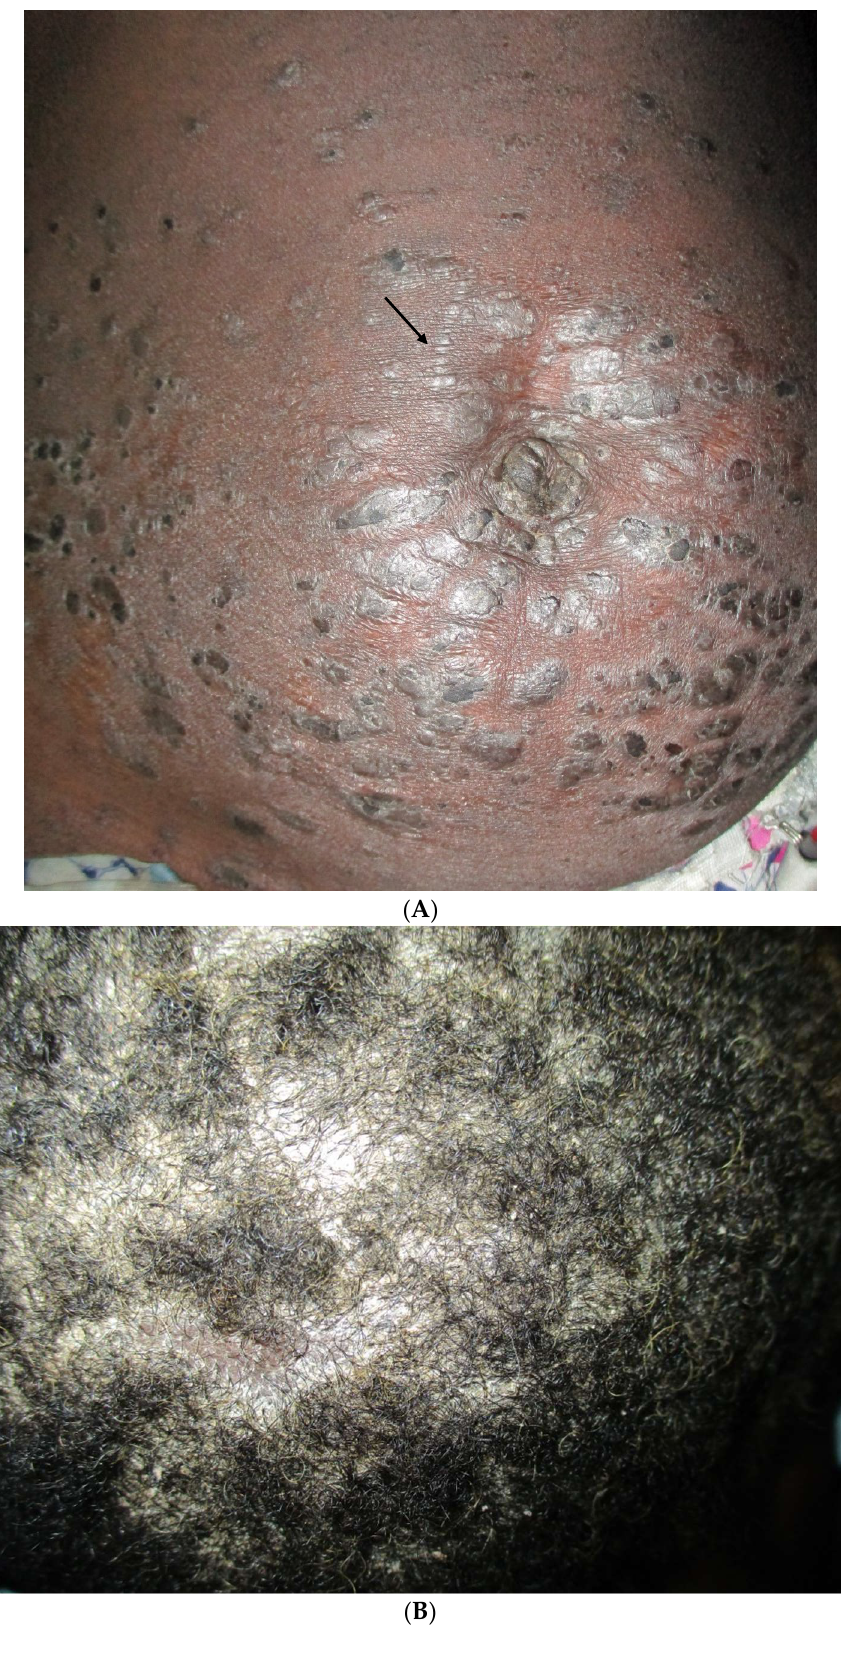
Figure 5. ( A ) Psoriasis in a 35-year-old woman: erythematous papules and plaque over the abdomen. Note the Köbner phenomenon; ( B ) Scalp involvement of the patient.